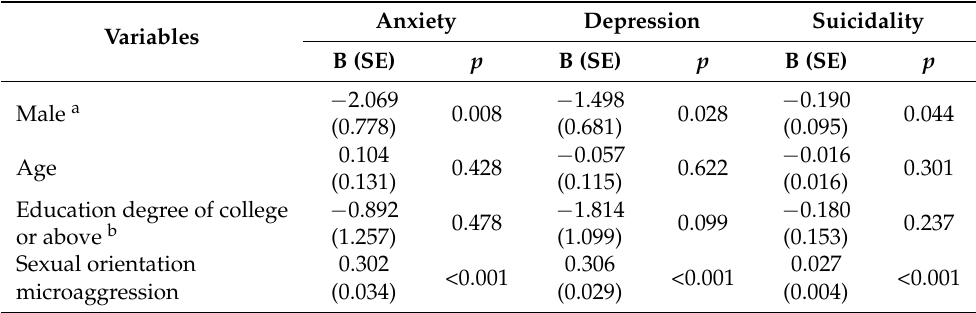
Table 3. Association of sexual orientation microaggression with anxiety, depression, and suicidality: Multivariate linear regression